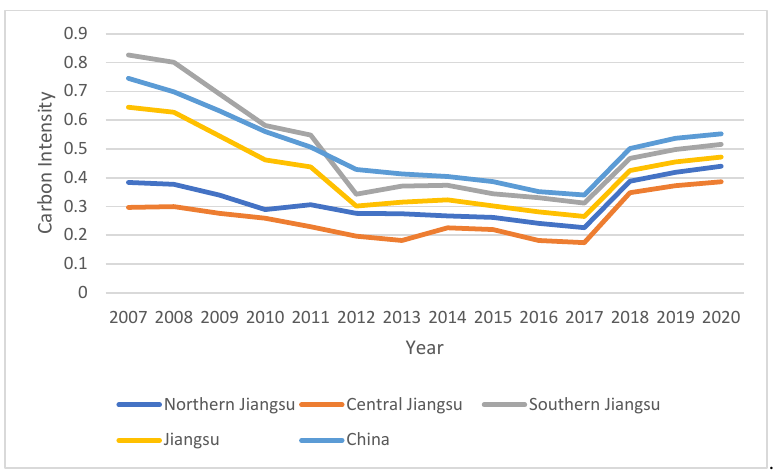
Figure 2. Carbon intensity in Jiangsu from 2007 to 2020.